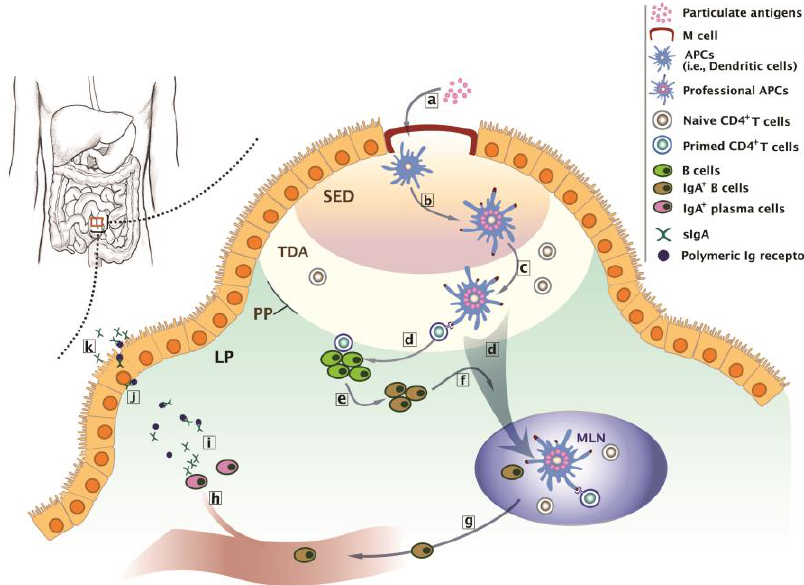
Figure 1. Biological basis of intestinal immunity at the Peyer’s patches (PP). ( a ) Transcytosis of particulate antigens to antigen presenting cells (APCs) such as DCs through M cell portal at the inductive sites. ( b ) Transformation of APCs to professional APCs after antigen-presentation at the subepithelial dome (SED). ( c ) Priming of naïve CD4 + T cells by professional APCs at the thymus-dependent area (TDA). ( d ) Activation of B cells by the primed CD4 + T cells, or active migration of professional APCs to the mesenteric lymph node (MLN) for further CD4 + T cell activation and subsequent IgA + B cell production. ( e ) Transformation of B cells to IgA + B cells. ( f ) Migration of IgA + B cells to the MLN. ( g ) The entrance of IgA + B cells to the systemic circulation through efferent lymph and thoracic ducts. ( h ) Accumulation of IgA + B cells at the lamina propria (LP) and maturation of IgA + B cells to IgA + plasma cells. ( i ) The release of dimeric or polymeric IgA from the IgA + plasma cells. ( j ) Migration of the complex of dimeric or polymeric IgA with polymeric Ig receptor toward the luminal surface of the intestine. ( k ) Transcytosis of the complex of and release sIgA at the effector sites.